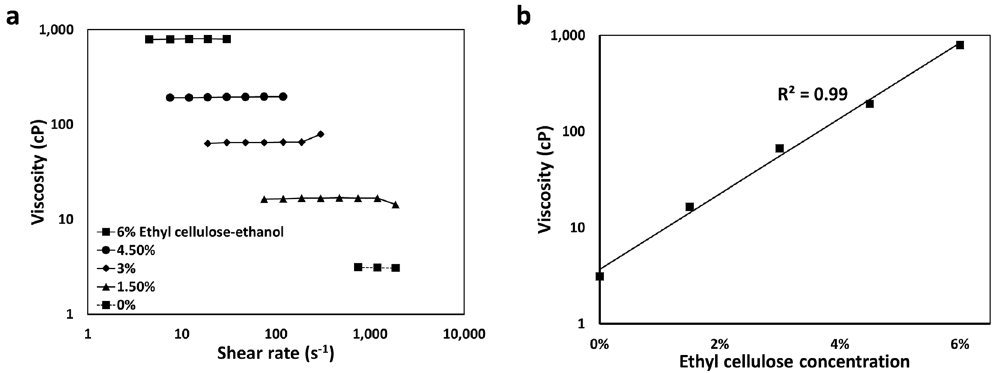
Figure 3. Ethanol viscosity increases with addition of ethyl cellulose. ( a ) Viscosity values were independent of shear rate. ( b ) Viscosity of ethanol increased with increasing ethyl cellulose